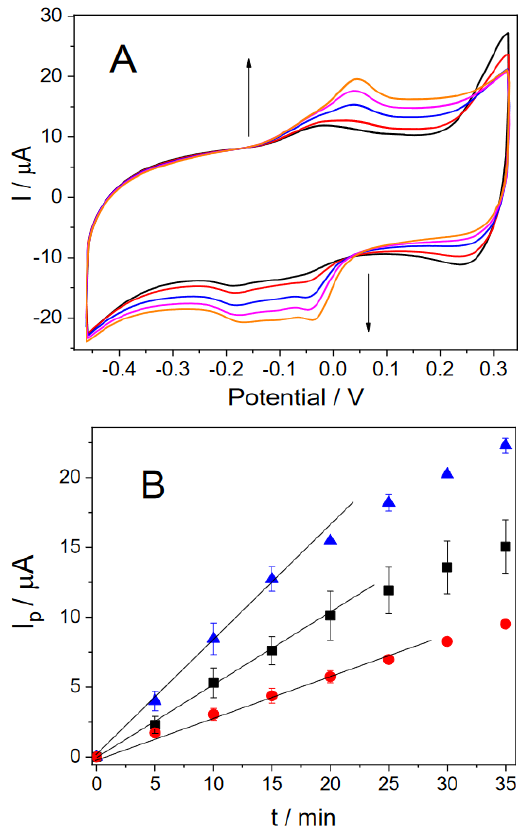
Figure 3. ( A ) Cyclic voltammograms recorded with ALP@AETAC-modified electrode in 0.5 mM HQ2P + 5 mM PO 43 − + 0.1 M trizma buffer solution (pH = 8.4) at 100 mV s − 1 under room atmosphere. Number of cycles: 19 (black line); 38 (red line); 76 (blue line); 114 (magenta line); 152 (orange line). ( B ) Current intensity of the oxidation peak as function of time obtained at different concentration of PO 43 − in solution 0.5 mM HQ2P + 0.1 M trizma buffer solution (pH = 8.4): 1 mM (blue triangles), 3.3 mM (black squares), and 5 mM (red circles).